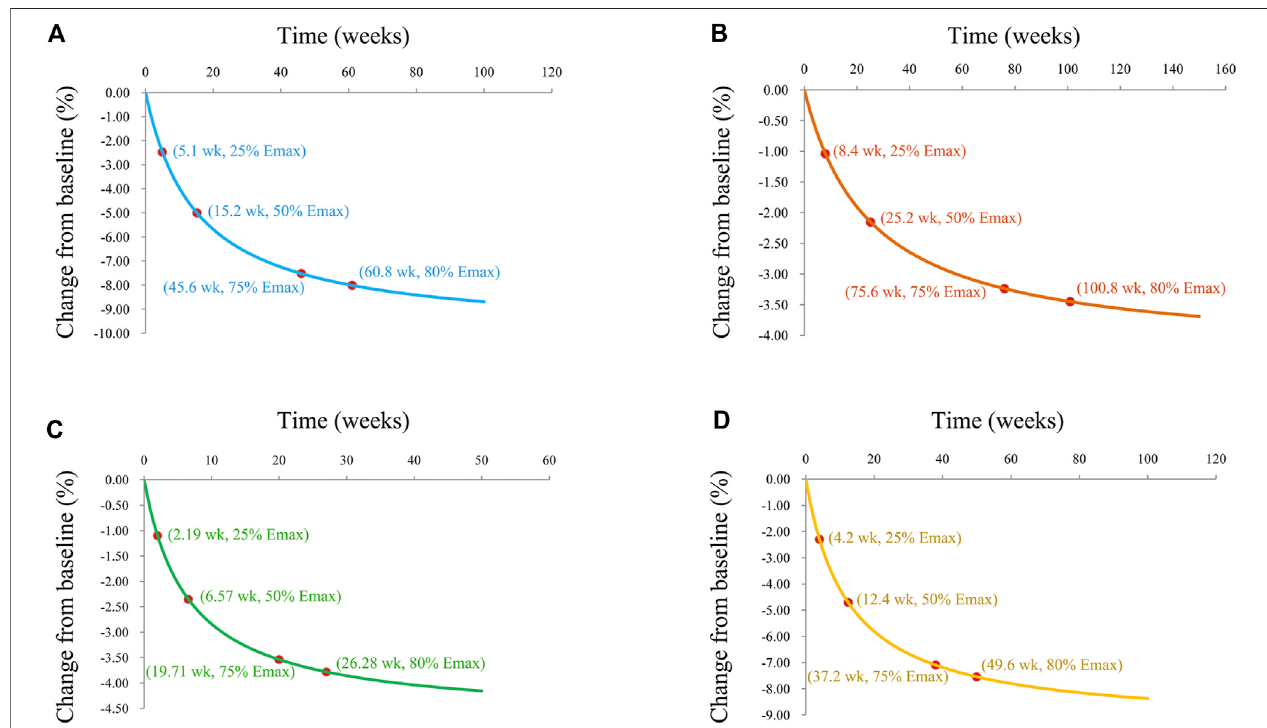
FIGURE4| Modelprediction. (A) Patientswithobesity, (B) patientswithtype1diabetesmellitus, (C) patientswithnonalcoholicfattyliver,and (D)